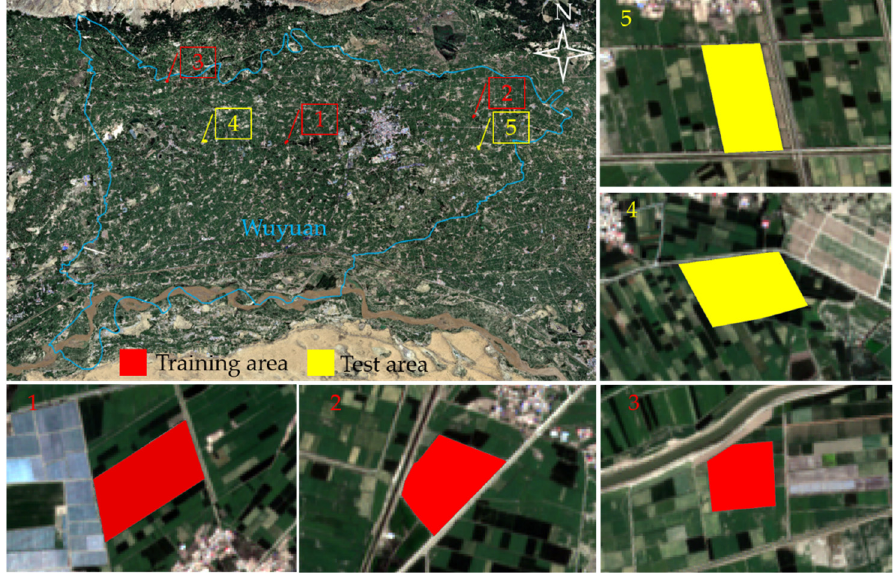
Figure 2. Remote sensing data acquisition area of